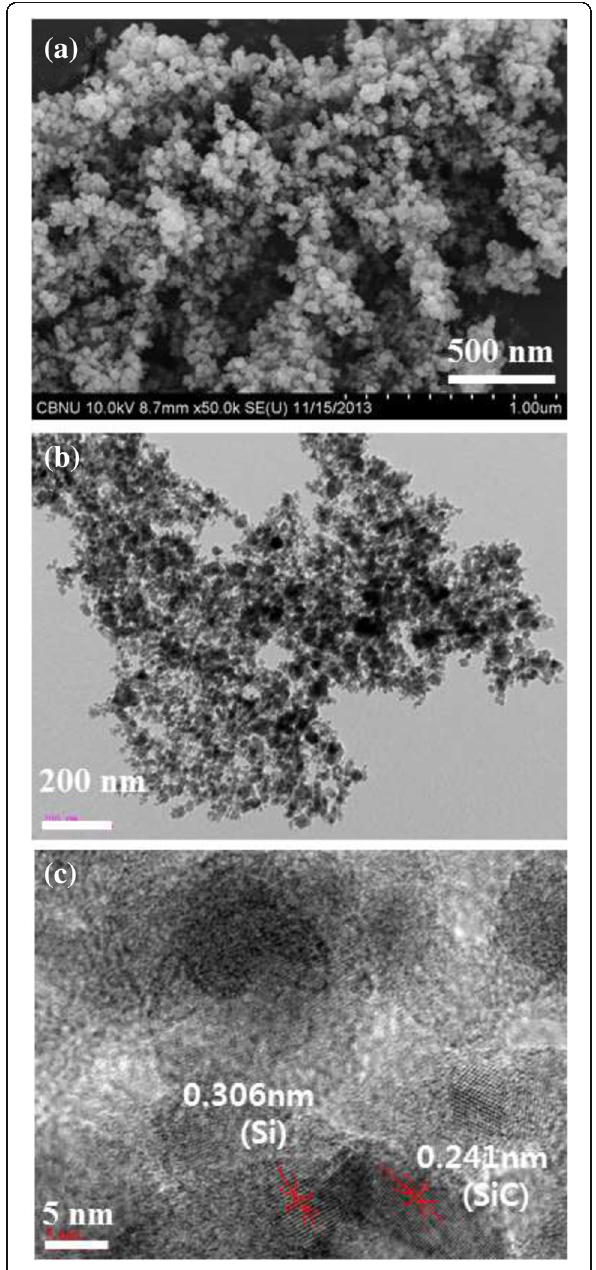
Fig. 3 EM images of Si-SiC composite particles prepared by non- transferred arc thermal plasma process: a FESEM, b TEM, and c